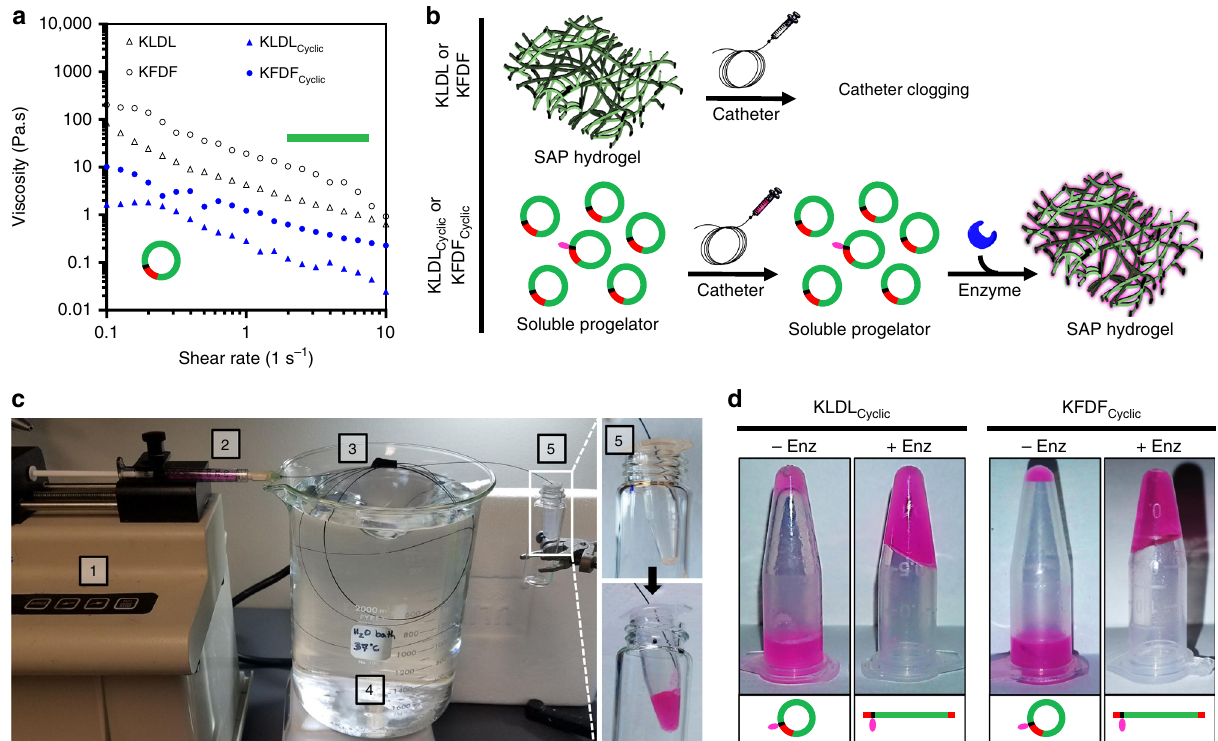
Fig. 7 In vitro catheter injection of low-viscosity progelators. a Complex viscosity of KLDL Cyclic (blue triangles) and KFDF Cyclic (blue circles) progelators reveal >20× decrease in comparison to corresponding unmodi fi ed KLDL (black triangles) and KFDF (black circles) self-assembling peptides (SAPs). b Schematic illustrating catheter applicability of KLDL and KFDF SAPs vs that of enzyme-responsive KLDL Cyclic and KFDF Cylic progelators. Injection of SAP hydrogels causes clogging. Clipart adapted from Servier ’ s Medical Art database (https://smart.servier.com). c Experimental setup of progelator (2 mol% labeled) catheter injection test. Peptide was (1) loaded in a 1 mL syringe, (2) mounted on a syringe pump, and (3) fl owed at 0.6 mL min − 1 through the inner nitinol tubing (27 G) of a MyoStar transendocardial injection catheter. The catheter was (4) submerged in a circulating water bath heated to 37 °C. The collection tube (5) before (top) and after (bottom) injection shows successful injection. d Photographs of KLDL Cyclic and KFDF Cyclic progelators (2 mol% labeled) after catheter injection into an empty vial (left) or a vial containing thermolysin (right), demonstrating that injection does not disrupt